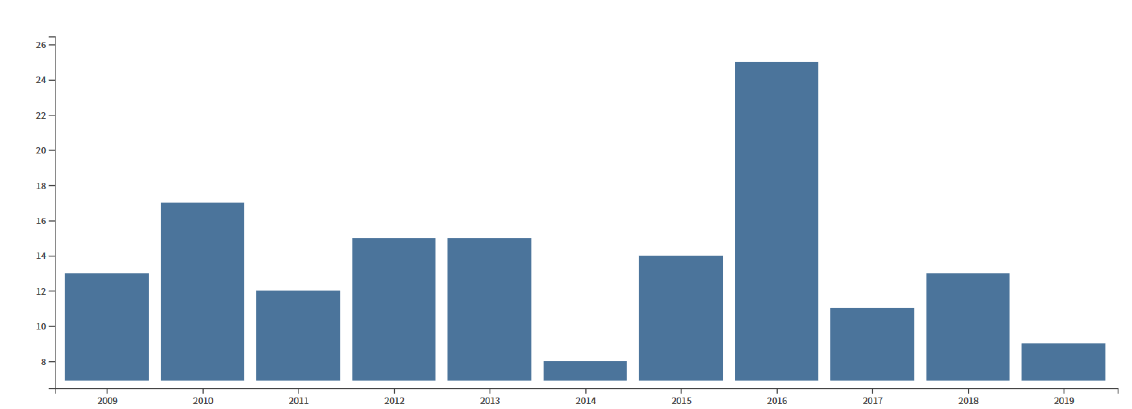
Figure 3. Scientific production regarding nature-inspired and the metaheuristic (NI&M)-based